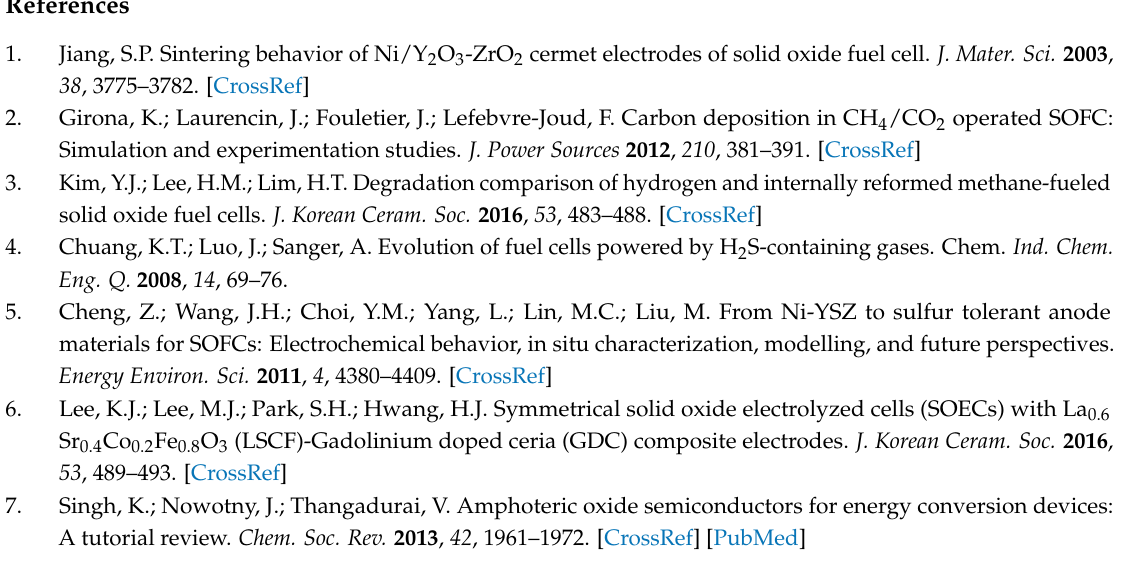
Figure S1. Nyquist plots of Ni-CGO- (a,b), Co- (c,d), and Fe- (e,f) infiltrated LSCTZ5 at different operating temperatures in 3% H 2 O/H 2 and 50% H 2 O/H 2 . Figure S2. Bode plots of Ni-CGO- (a,b), Co- (c,d), and Fe- (e,f) infiltrated LSCTZ5 at different operating temperatures in 3% H 2 O/H2 and 50% H 2 O/H 2